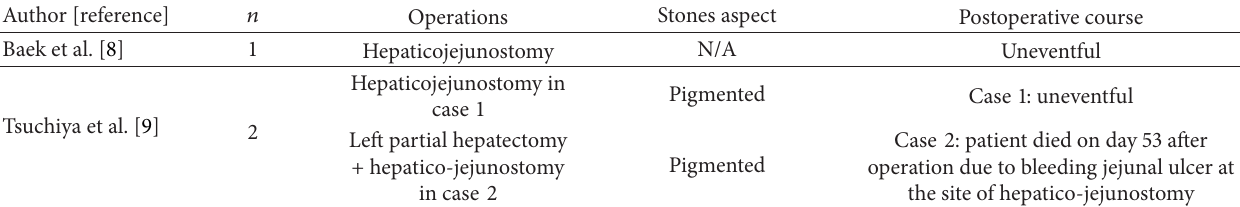
Table 1: Different treatment modalities adopted in patients with hepatolithiasis due to right hepatic artery syndrome.